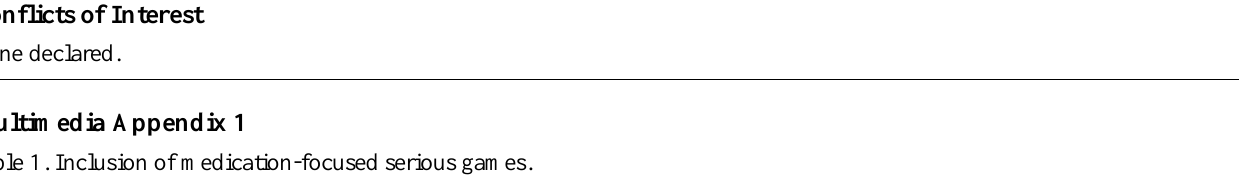
Table 1. Inclusion of medication-focused serious games.